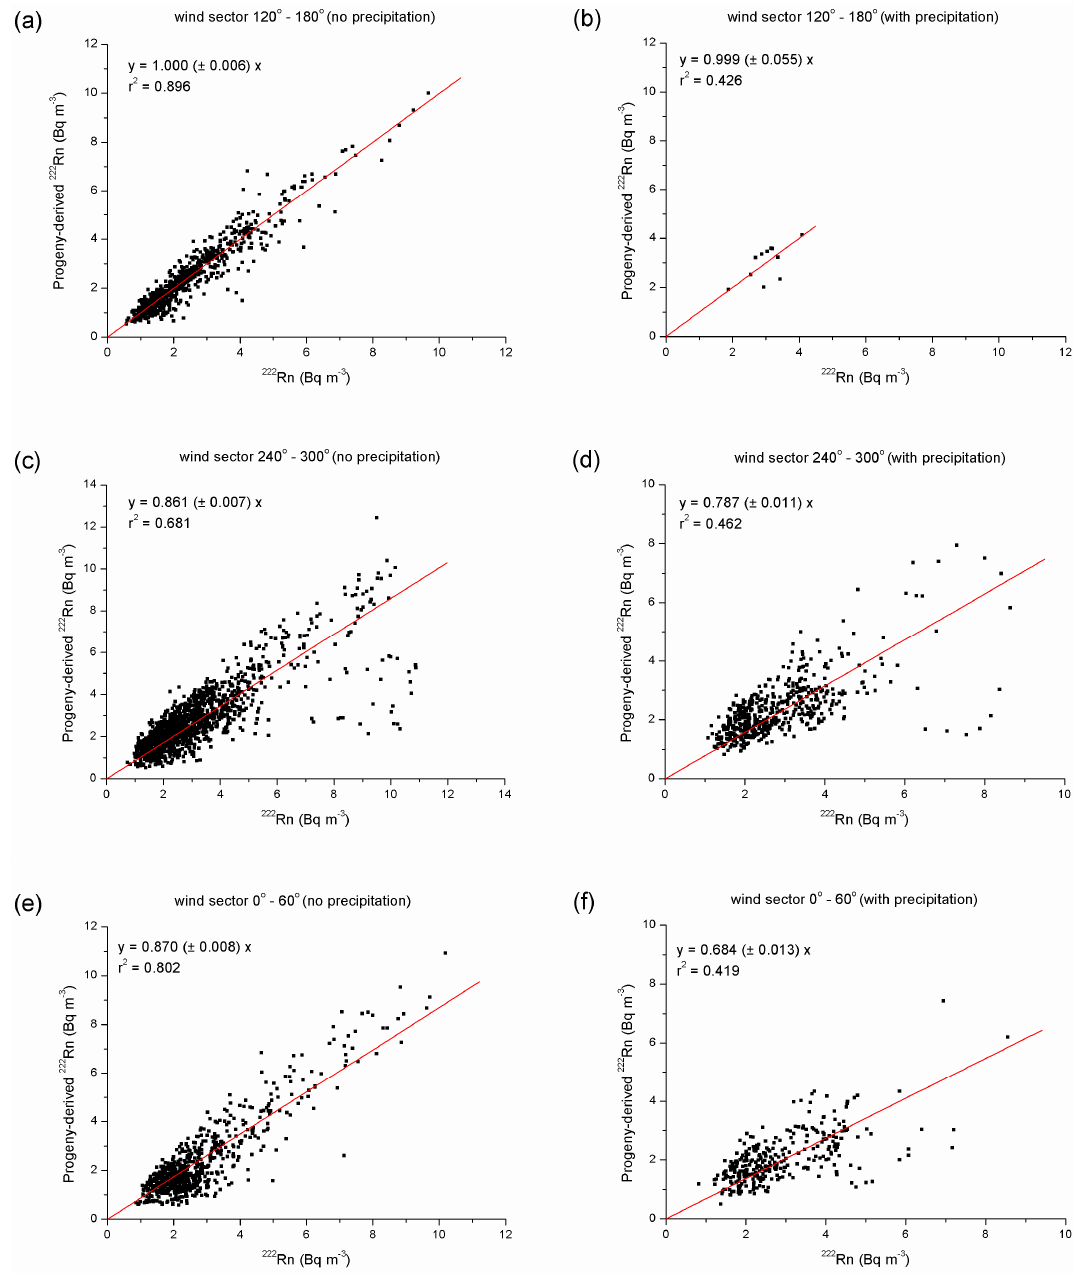
Fig. 7. Correlation between activity concentration of progeny-derived 222 Rn and 222 Rn for the reference sector (a, b) and the two sectors influenced by forest cover (c, d, e, f) , for without precipitation (a, c, e) and with precipitation (b, d, f) (values in brackets are standard errors of regression parameters). Instrumental background and calibration have been harmonised between detectors.